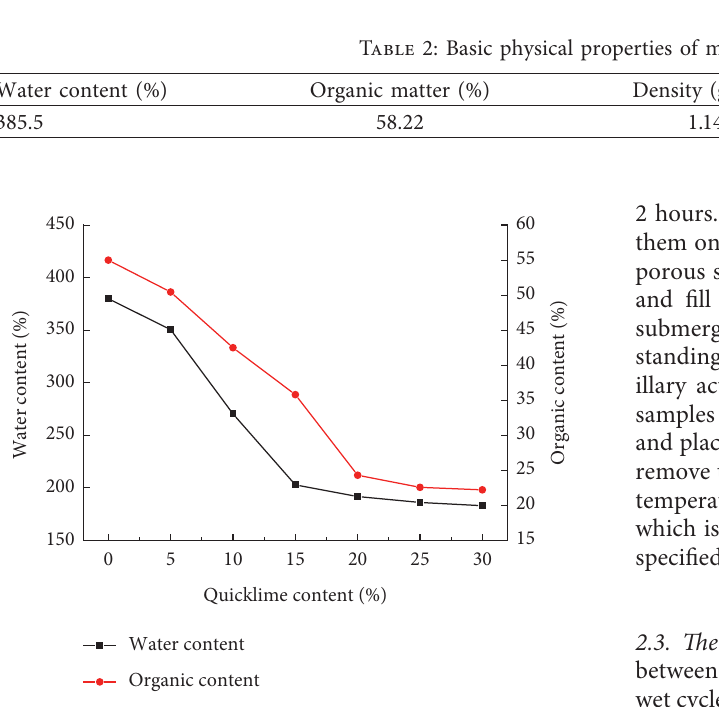
Figure 1: Effect of quicklime content on water content and organic matter content in municipal